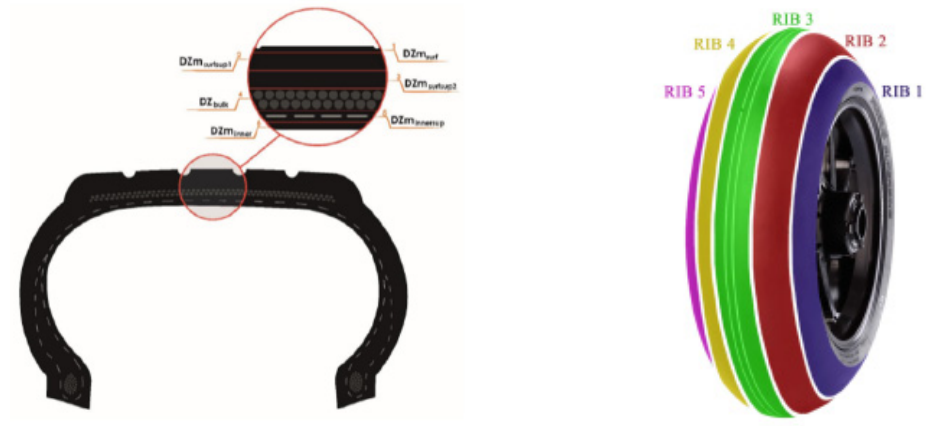
Figure 2. Example of thermoRIDE tire mesh configuration.